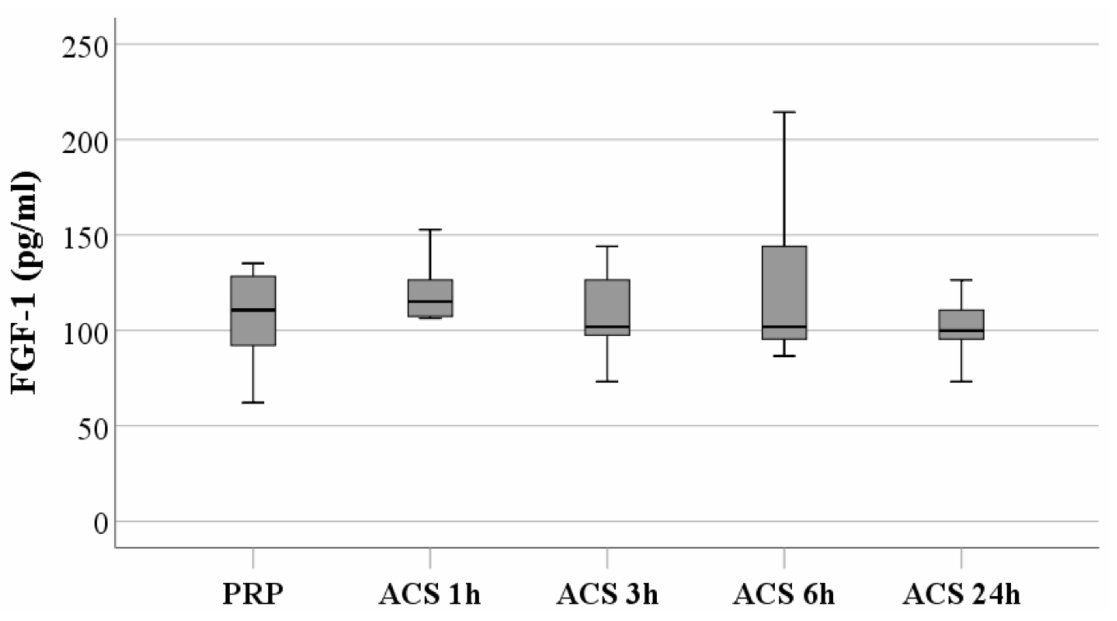
Figure 1. Fibroblast growth factor (FGF)-1 levels of platelet-rich plasma (PRP) and autologous conditioned serum (ACS) with different incubation times. No significant difference was found.